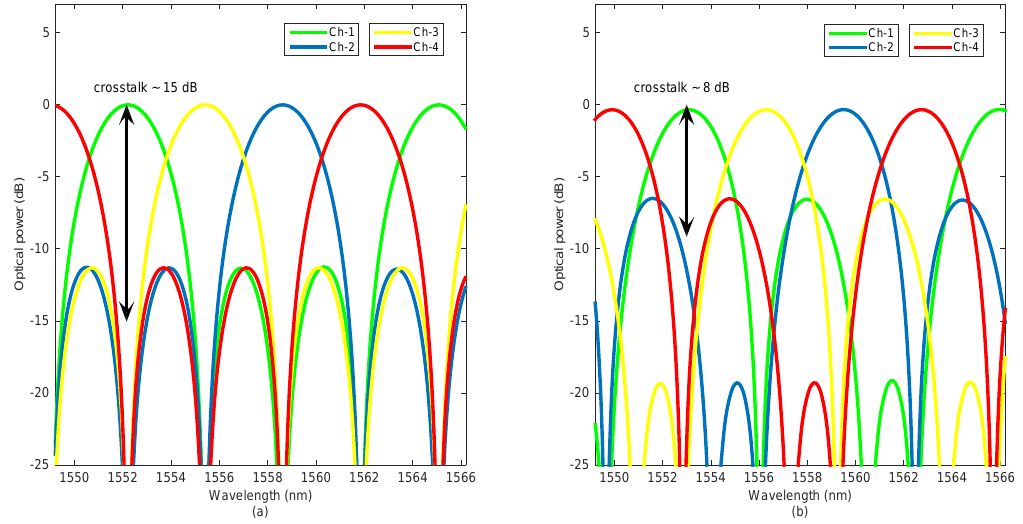
Figure 5. Simulation result of the ( a ) overlapped transmission responses of the four optical output channels and ( b ) overlapped transmission responses of the four optical output channels in the presence of a delay length mismatch error 100 nm.